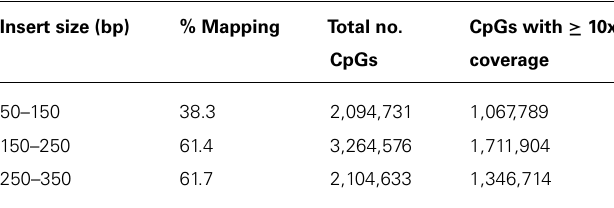
Table 1 | Mapping efficiencies and CpG coverage of libraries created with different insert sizes: 50–150, 150–250, and 250–350 bp. Insert size (bp)